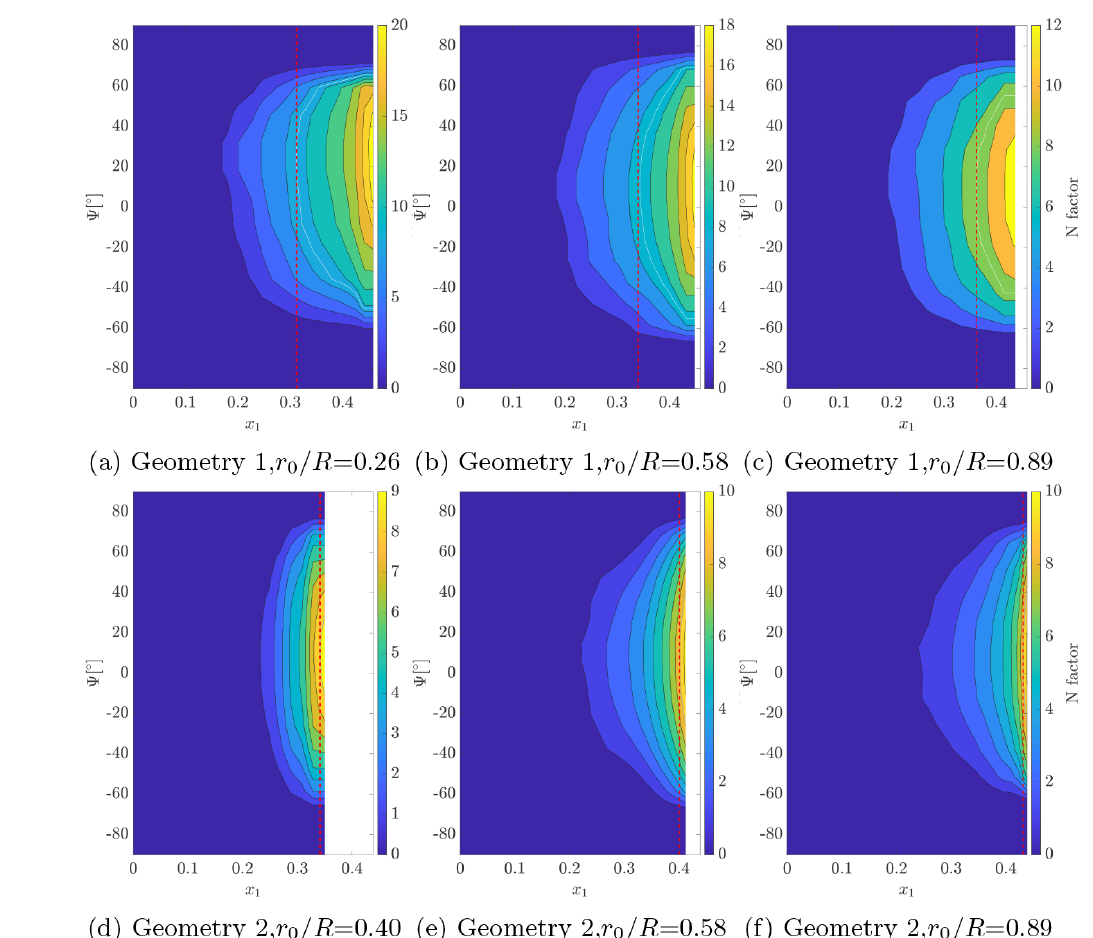
Figure 12. N -factor contours from PSER 2D for three radial positions. The white line indicates the critical region, and the red dashed line shows the transition